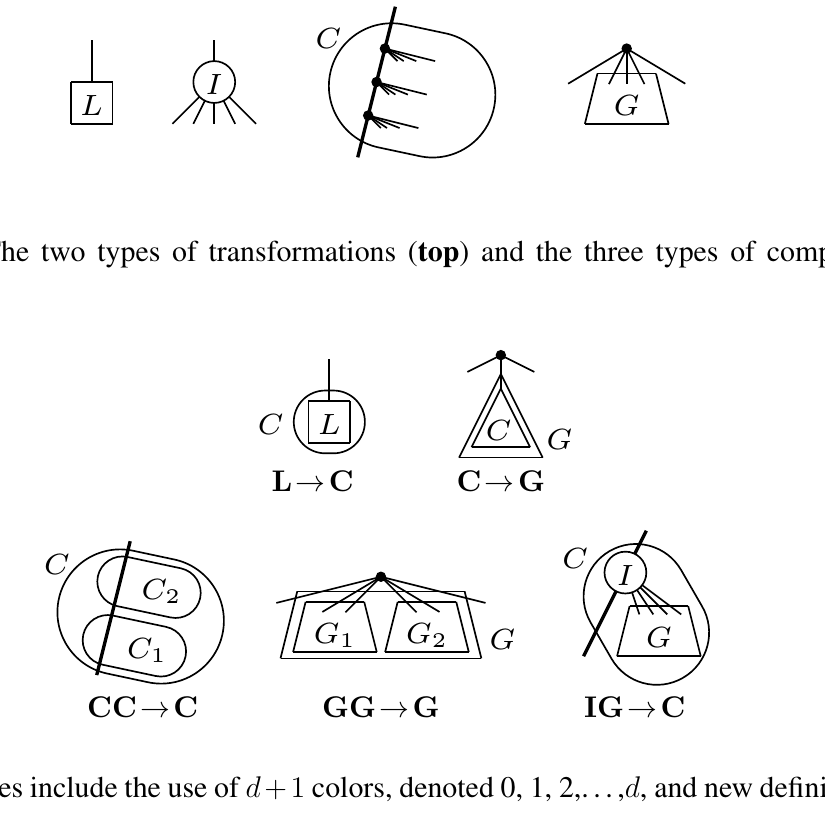
Figure 10. The four different types of components.